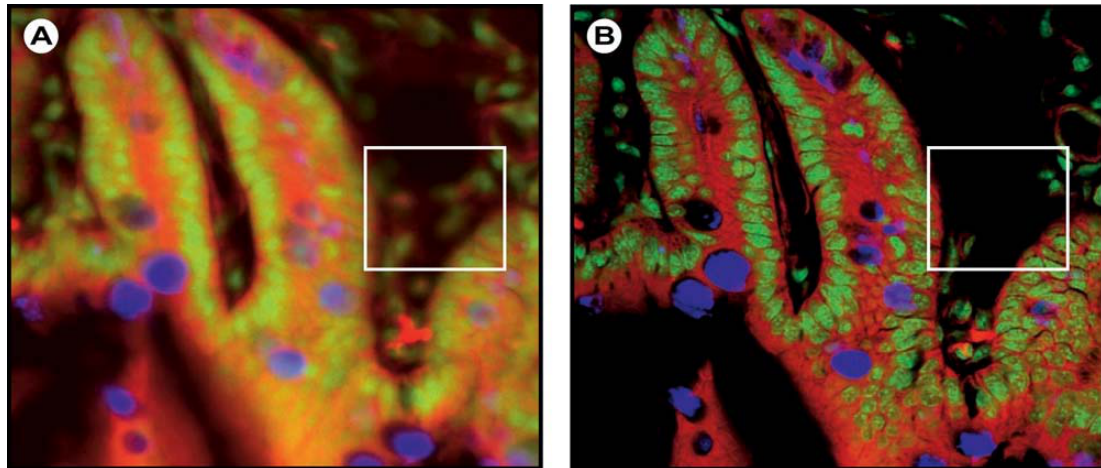
Figure 8. Confocal versus wide field microscopy. Wide field ( A ) and confocal ( B ) image of a triple-labeled cell aggregate (mouse intestine section). In the wide field image, specimen planes outside the focal plane degrade the information of interest from the focal plane, and differently stained specimen details appear in mixed color. In the confocal image ( B ), specimen details blurred in wide field imaging become distinctly visible, and the image throughout is greatly improved in contrast. Notice that out of focus signals in the wide field image cause additional structures to appear (white box). Reproduced